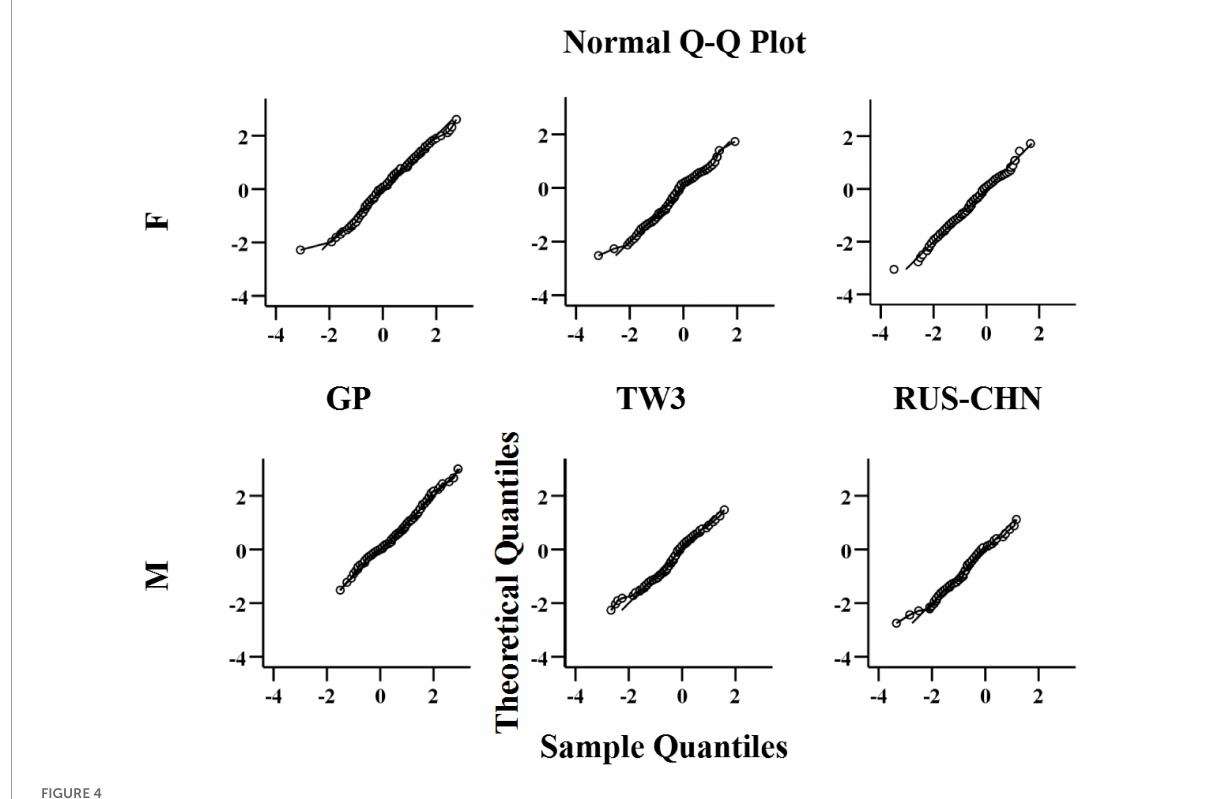
FIGURE4 Q-Q plots for D, by sex, for females (top) and males (bottom).